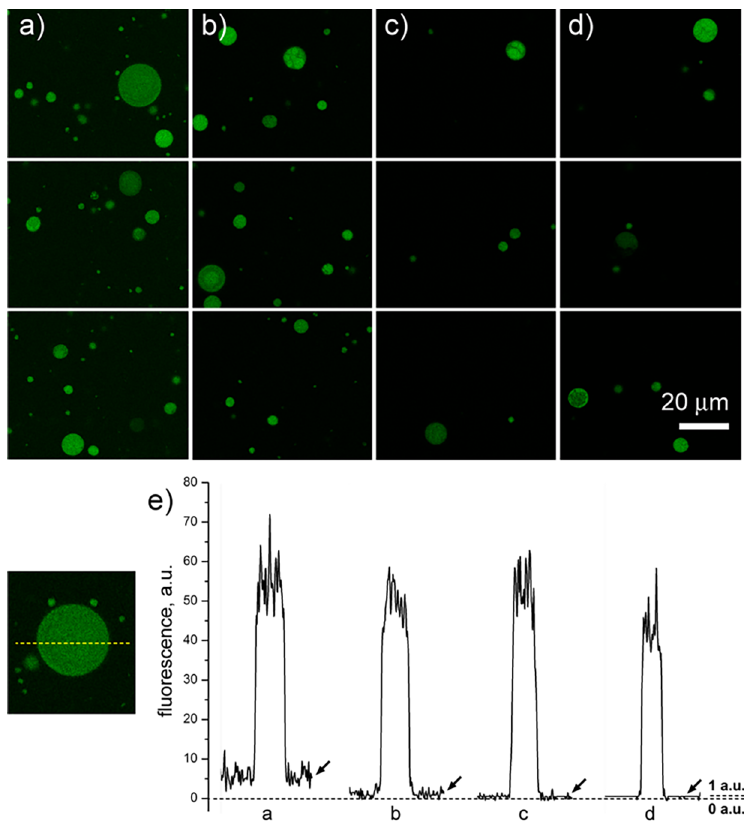
Fig 3. Confocal images and fluorescence profiles of GV samples as obtained by successive microfiltration. (a) Before filtration (after dilution); (b) first retentate; (c) second retentate; (d) third retentate. In (e), typical fluorescence densitometric profiles along GV images are presented, and refer to the (a-d) samples shown on the top. The profiles show the fluorescence intensities along a line drawn over a GV image, see the example on the left. Note that the fluorescence outside vesicles–indicated by arrows–decreases from ca. 6 a.u. (profile ‘a’), to ca. 1 a.u. (profile ‘d’). This latter small value (1 a.u.) cannot be further reduced, as it actually represents the minimal measurable value. Samples consist of calcein-filled DOPC/DOPA 7:3 mol/mol GV in 25 mM Tris-HCl, pH 7.5; see details in Table